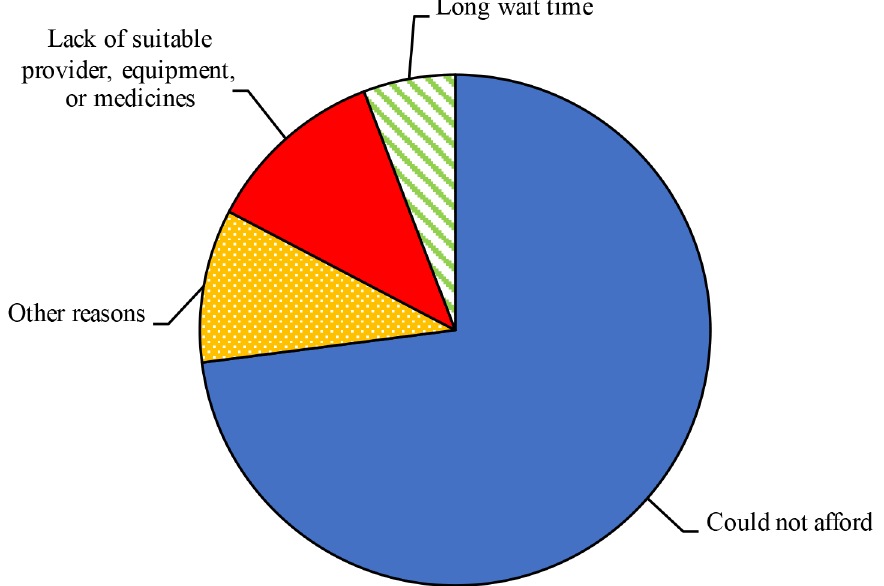
Fig 2. Reasons for not seeking care.